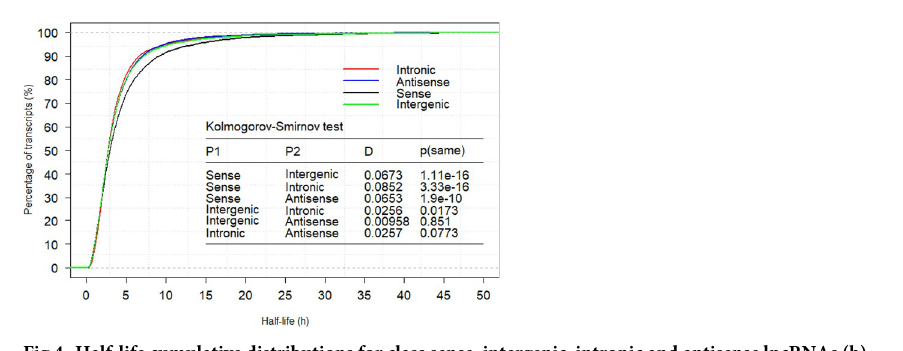
Fig 4. Half-life cumulative distributions for class sense, intergenic, intronic and antisense lncRNAs (h).